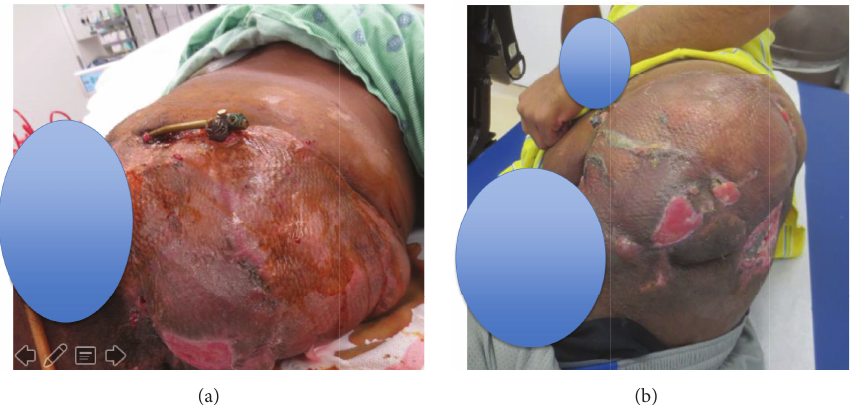
Figure 4: (a) Wound healing and (b) the fixator removed.